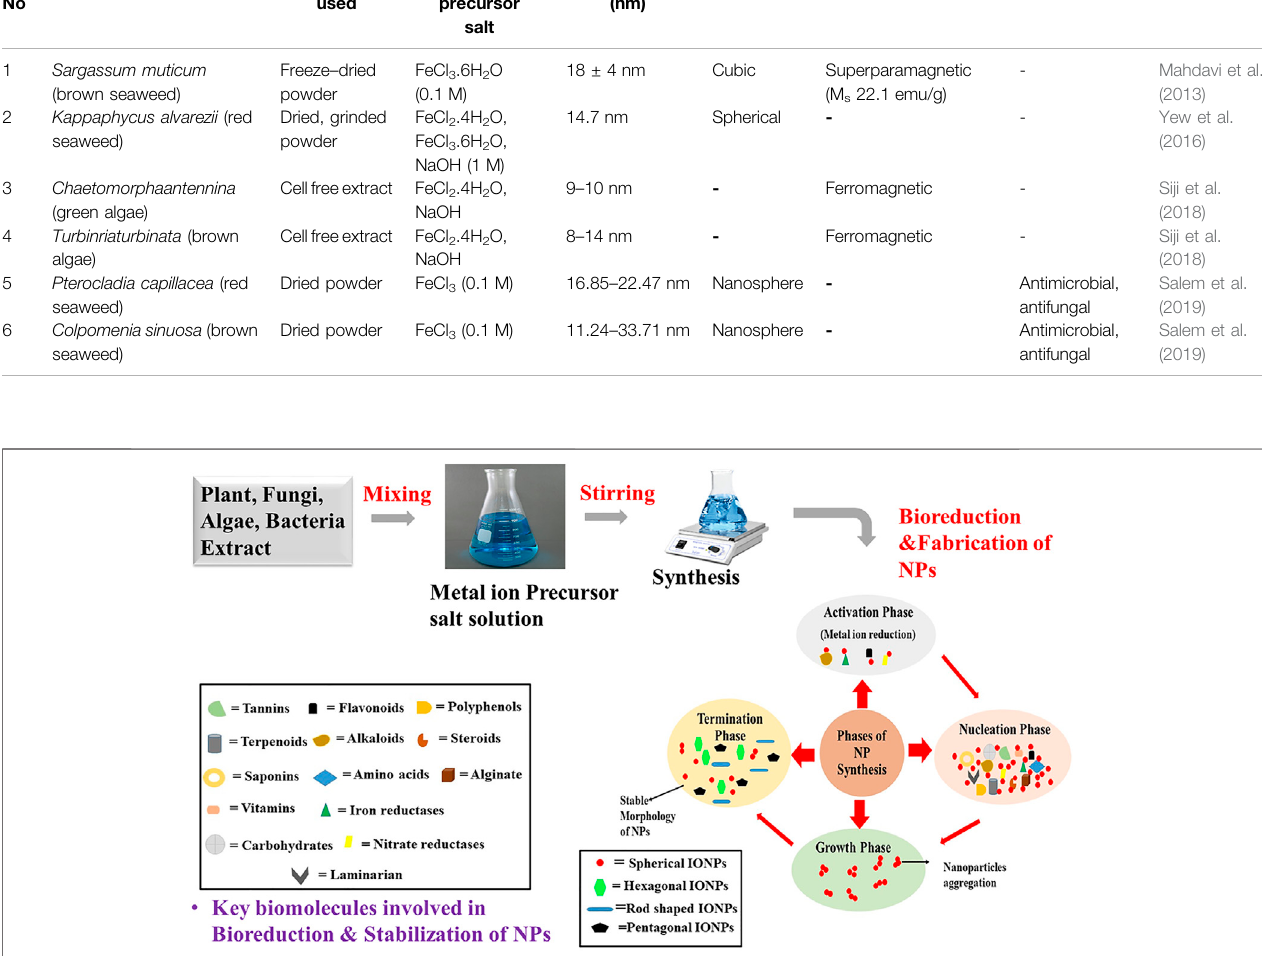
TABLE 4 | Biosynthesis of IronOxide nanoparticles by using algae. Sr No